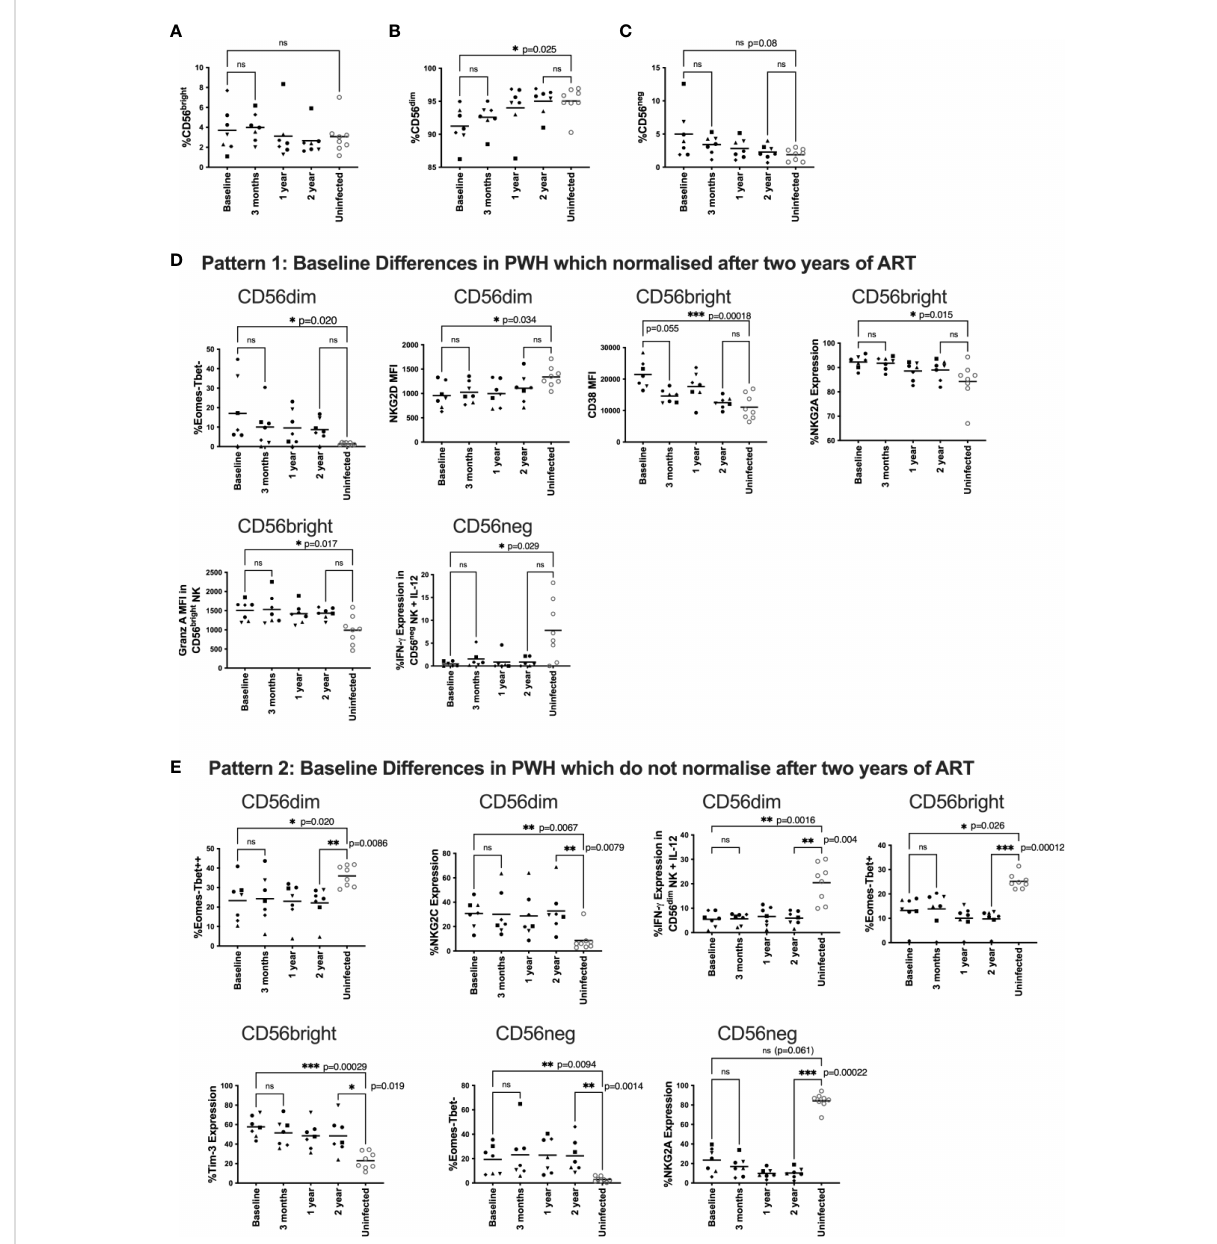
FIGURE 1 Changes to NK phenotype and function longitudinally on ART.PBMC from HEATHER samples were taken at baseline (off ART), 3 months, 1 year and 2 years post ART and compared to HIV uninfected individuals. HEATHER samples (n = 7) and HIV uninfected samples (n = 8) were stained for CD56 and analysed based on the expression of this marker into CD56 bright , CD56 dim , and CD56 neg NK cells at each timepoint (A – C) . Downstream analysis was performed on phenotypic and functional markers within the CD56 expressing populations. These are grouped to show those that were statistically different at baseline between PWH and HIV negative controls but then either corrected after two years of ART (D) , or remained statistically different after two years of ART (E) . For panels (D, E) , phenotypic and functional markers are presented as percent expression or median fl uorescence intensity (MFI). For all data, only samples with statistical differences between HIV infected and HIV uninfected individuals are shown. A Kruskal-Wallis test with Dunn ’ s multiple comparison test was performed between baseline and 3 months ART, baseline and uninfected samples, and 2 year and uninfected samples. *P < 0.05; **P < 0.01; ***P < 0.001; ns not signi fi